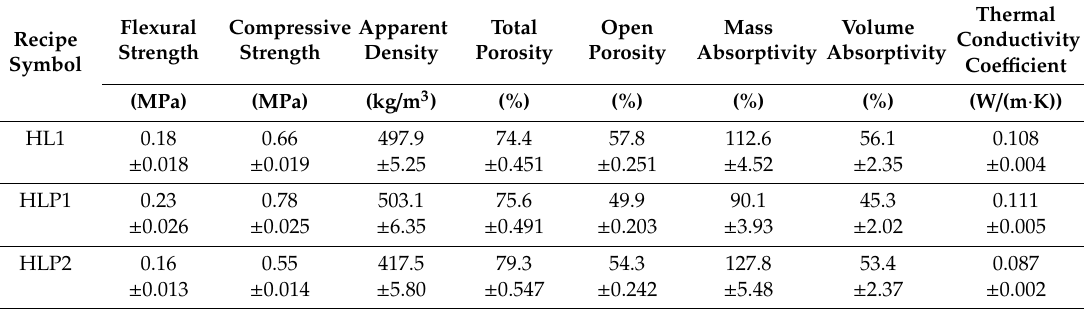
Table 3. Mechanical and physical properties of composites (average value ±